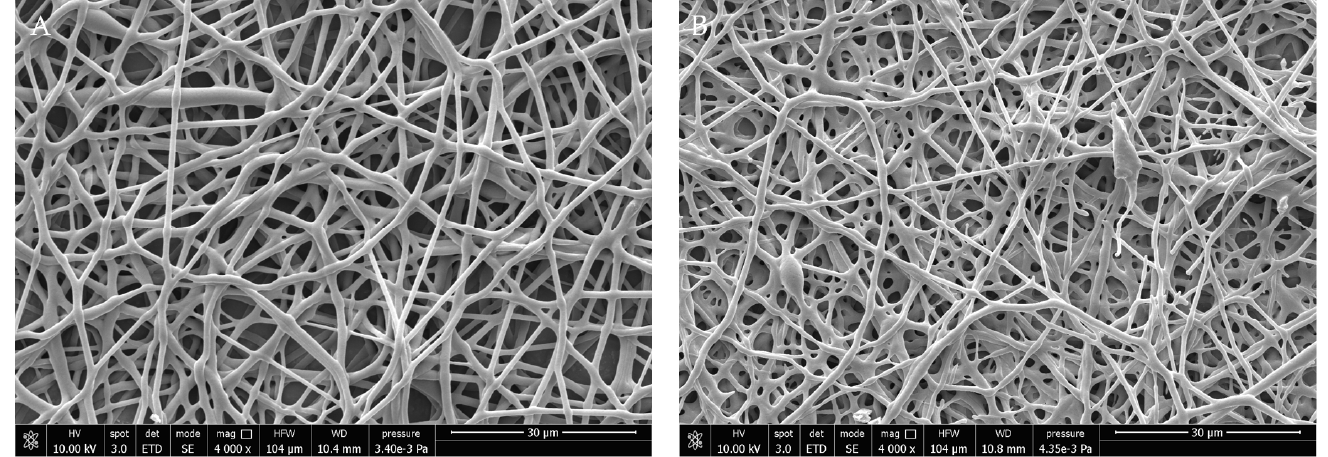
Figure 1. SEM micrographs of ( A ) PHBHV and ( B ) PHBHV/OLE electrospun fibers. Scale bar is 20 µm, 4000× magnification, 10 kV voltage. FT-IR ATR spectra, acquired for plain OLE, PHBHV, and PHBHV/OLE fiber samples are shown in Figure 2.